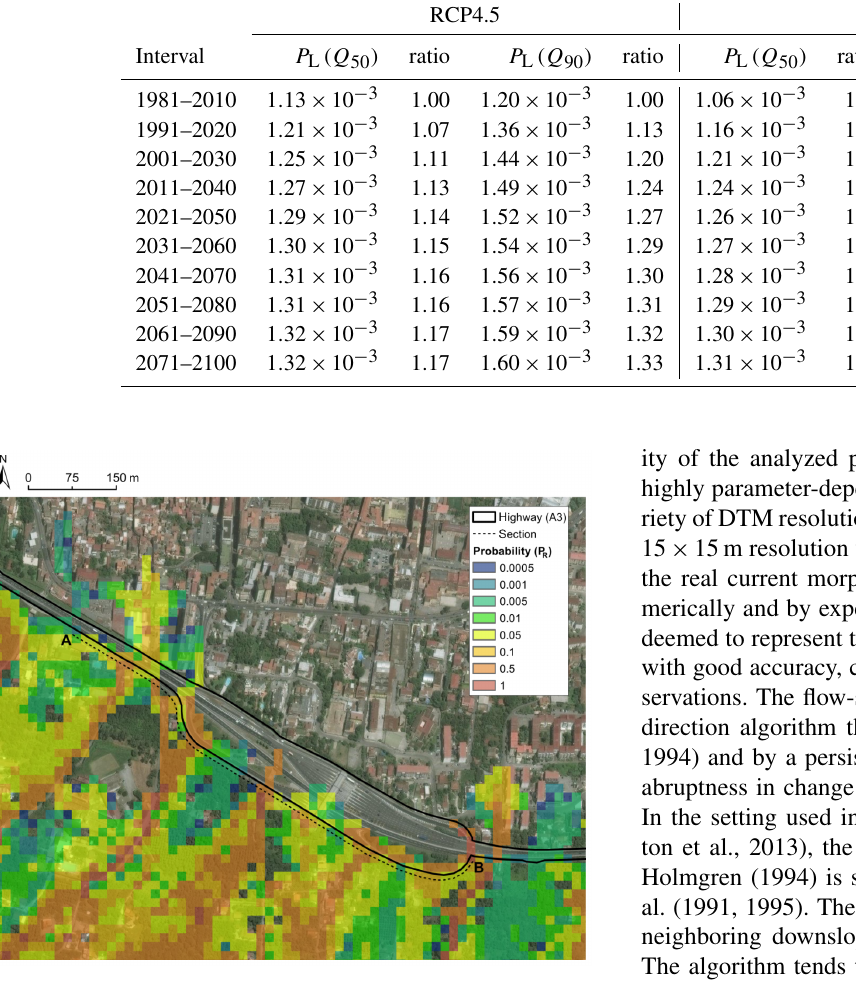
Figure 12. Spatial distribution of reach probability at infrastructure scale and indication of section